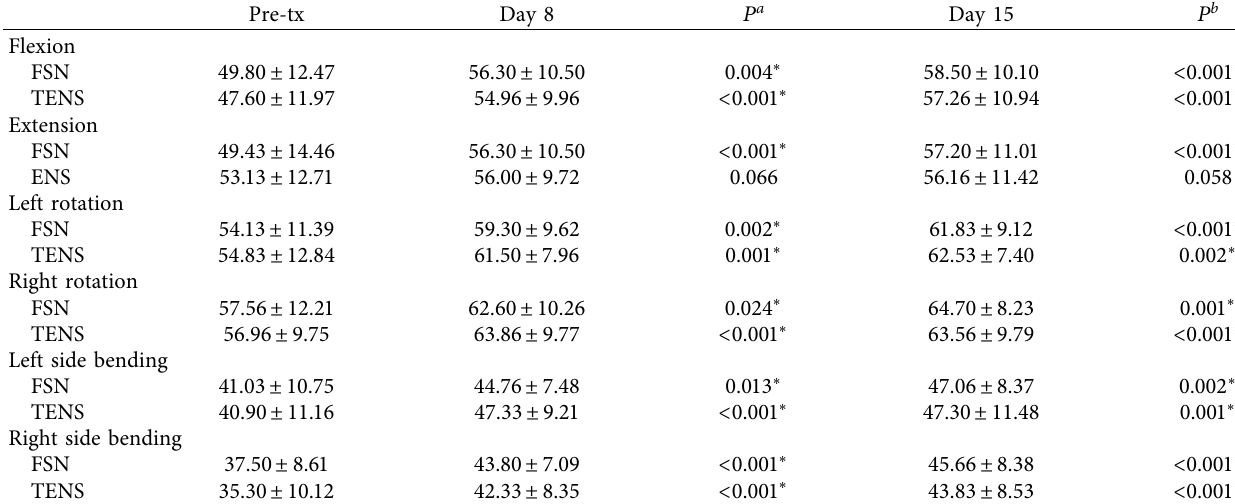
Table 6: Short-term and long-term effects of FSN and TENS groups on NROM.